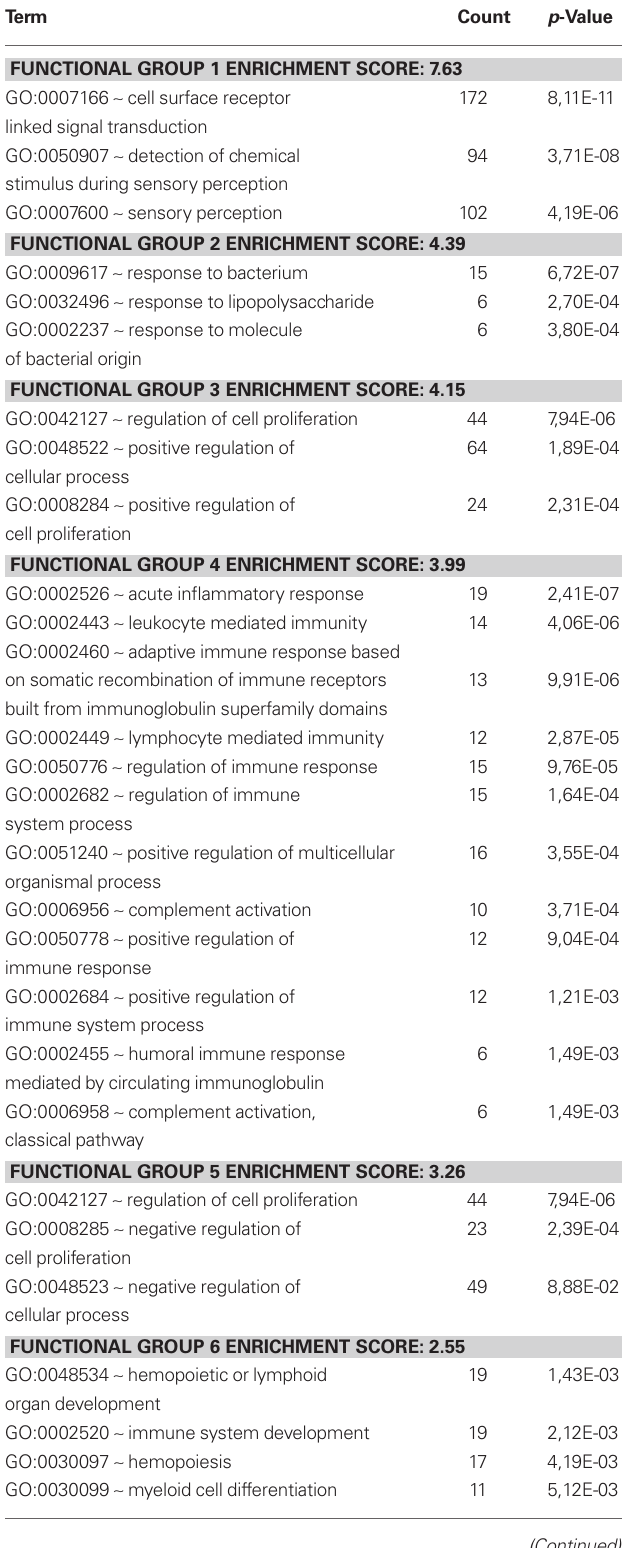
Table 2 | Avulsion vs control. A cluster analysis of the response to avulsion. Themes related to inflammatory response are enriched in this